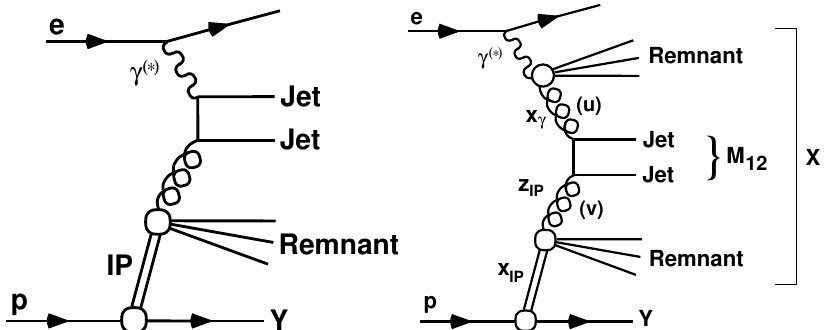
Figure 1: Diffractive production of dijets with invariant mass M resolved (right) photon-pomeron collisions, leading to the production of one or two additional remnant jets. The hadronic systems X and Y are separated by the largest rapidity gap in the final